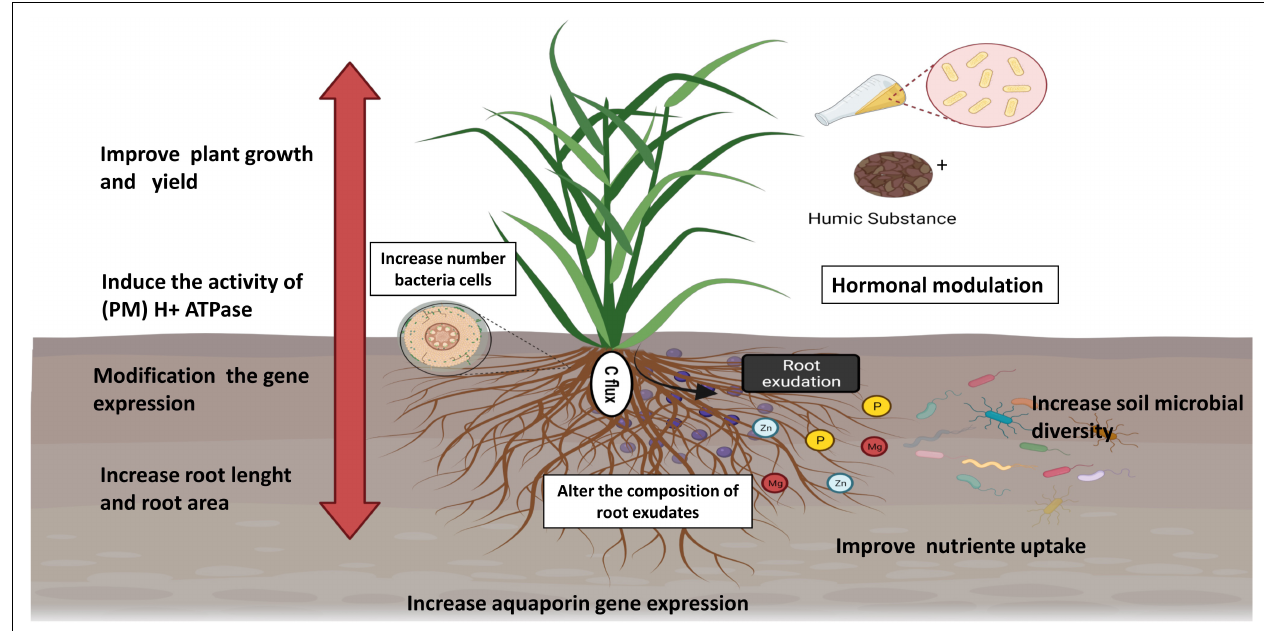
FIGURE 3 | Effect of HSs and PGPB application on plant growth. Figure created using BioRender